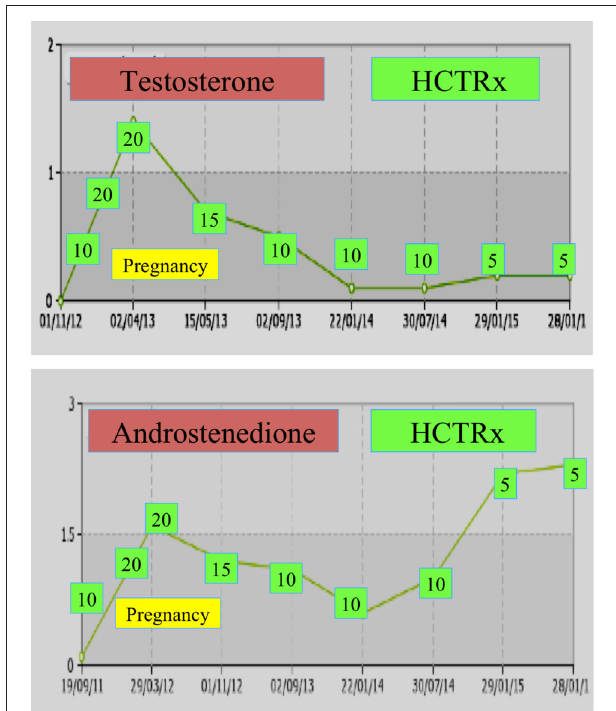
FIGURE 1 | Testosterone and andostenedione levels and subsequent hydrocortisone dosing (HCTRx), from conception until 3 years post-delivery administered to a patient with